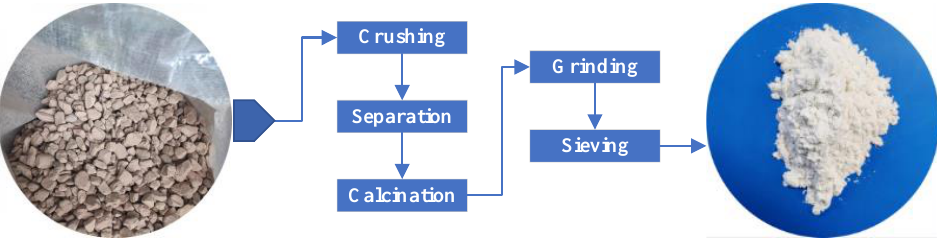
Figure 1. Preparation process of diatomite.